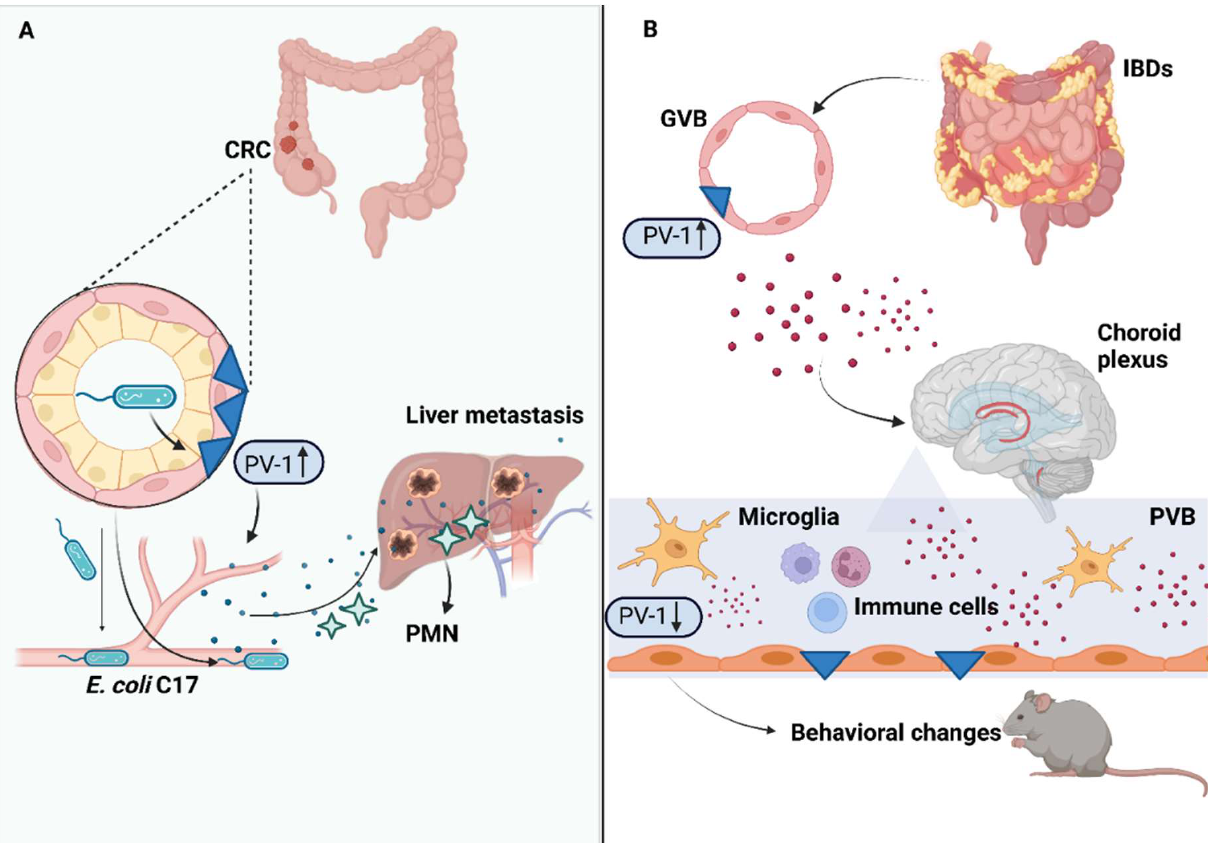
Figure 2. Influence of GVB disruption in colorectal cancer progression and in gut–brain axis function. Panel ( A ): In colorectal cancer, increased PV-1 expression is associated with disease progression. Microbiota may be a driver of this process, as bacterial dissemination of E. coli C17 from CRC lesions to the liver promotes the development of a premetastatic niche, favoring metastatic diffusion by disrupting the GVB. Panel ( B ): GVB damage occurs as a consequence of intestinal inflammation in IBDs and is associated with increased PV-1 expression. Intestinal inflammation drives immune cell activation in the brain. The PVB reacts to peripheral inflammation, increasing endothelial sealing to protect gut–brain axis homeostasis, a mechanism which has been linked to behavioral and cognitive impairment. Abbreviations: GVB: gut–vascular barrier; CRC: colorectal cancer; PMN: premetastatic niche; PV-1: Plasmalemma-vesicle associated protein-1; PVB: choroid plexus vascular barrier; IBDs: inflammatory bowel diseases. Created with